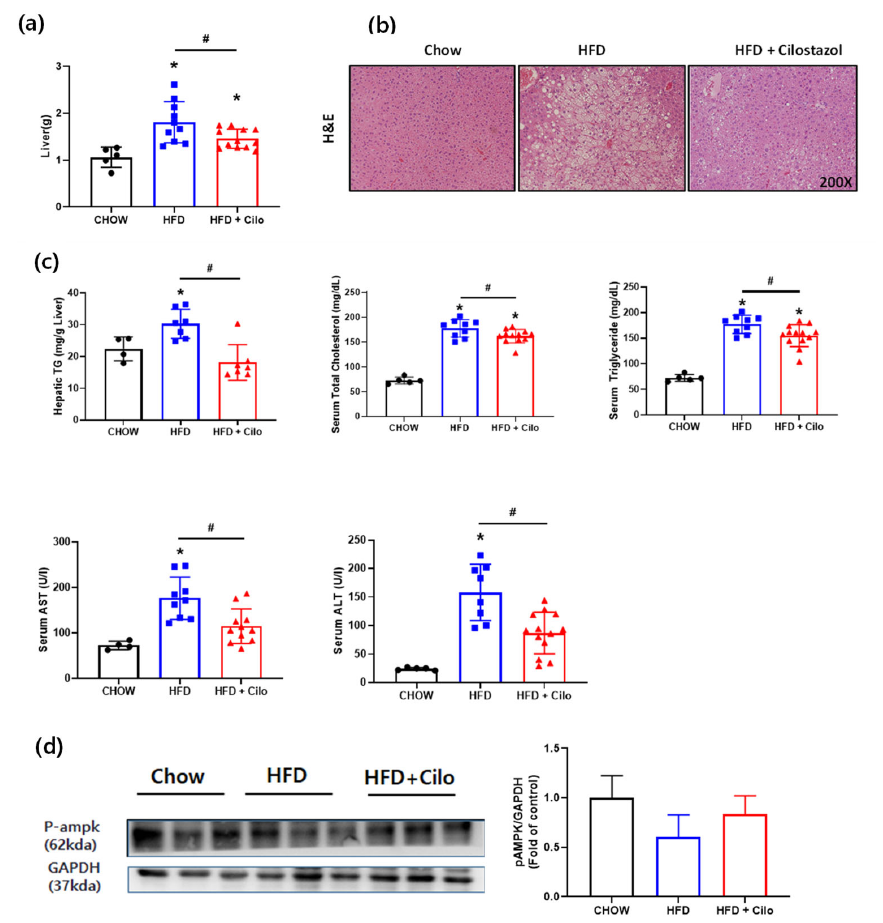
Figure 6. Cilostazol-attenuated HFD-induced hepatic steatosis. ( a ) Liver weight; ( b ) hematoxylin and eosin (H&E) staining of liver sections. Magnification, ×200; ( c ) hepatic TG concentration, serum total cholesterol, triglyceride, aspartate aminotransferase (AST), and alanine aminotransferase (ALT) levels; ( d ) protein levels of phosphorylated AMP-activated protein kinase (pAMPK) in the liver were determined using Western blot analysis. The graph on the right shows the densitometric analysis of the pAMPK/glyceraldehyde 3-phosphate dehydrogenase (GAPDH) ratio determined from the immunoblots shown on the left. * p < 0.05 vs. corresponding chow control value and # p < 0.05 vs. corresponding HFD control value. HFD, high fat diet; Cilo,